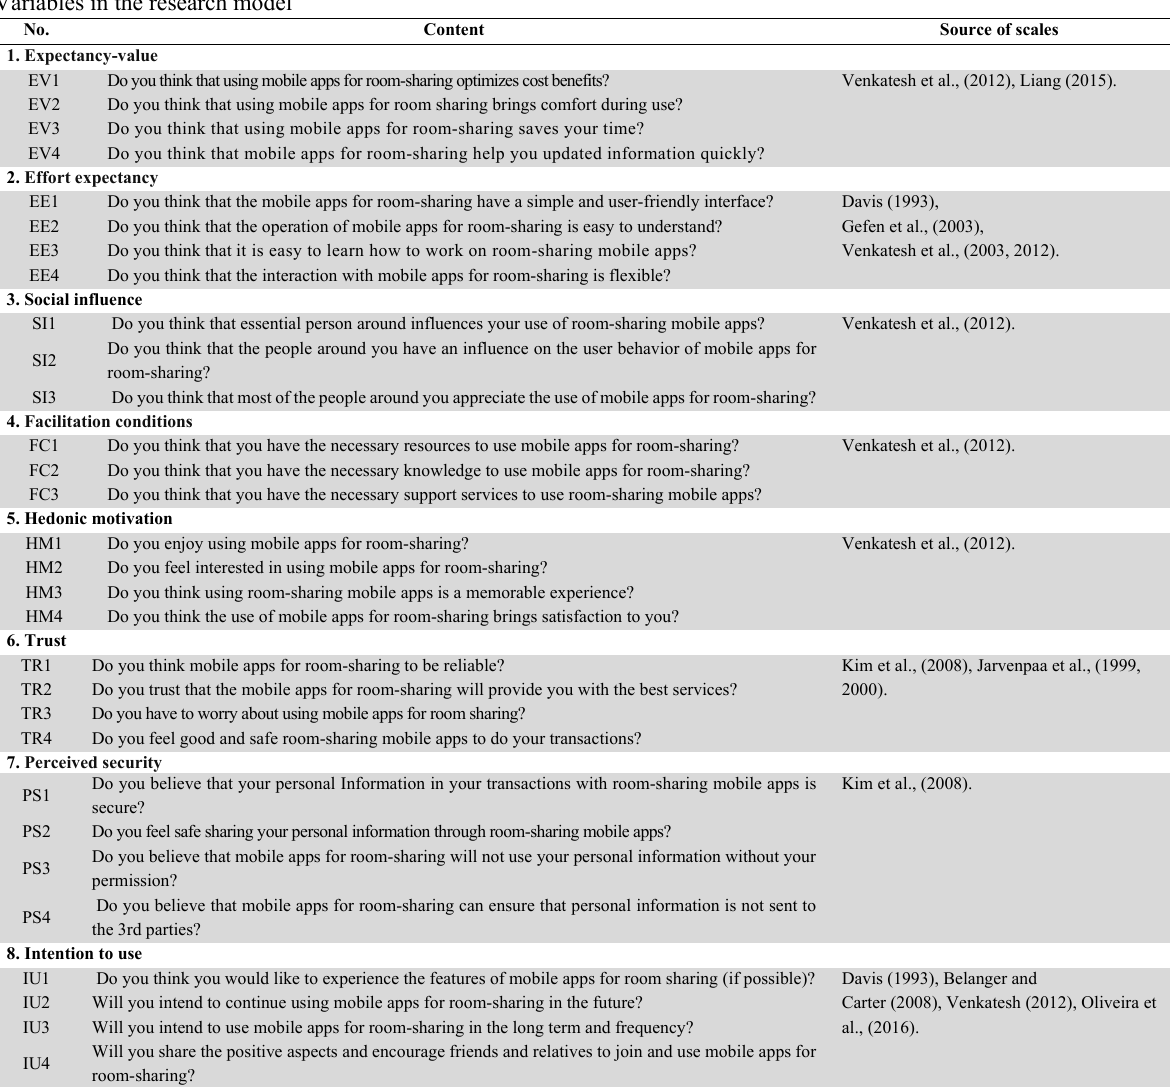
Variables in the research model Content Source of